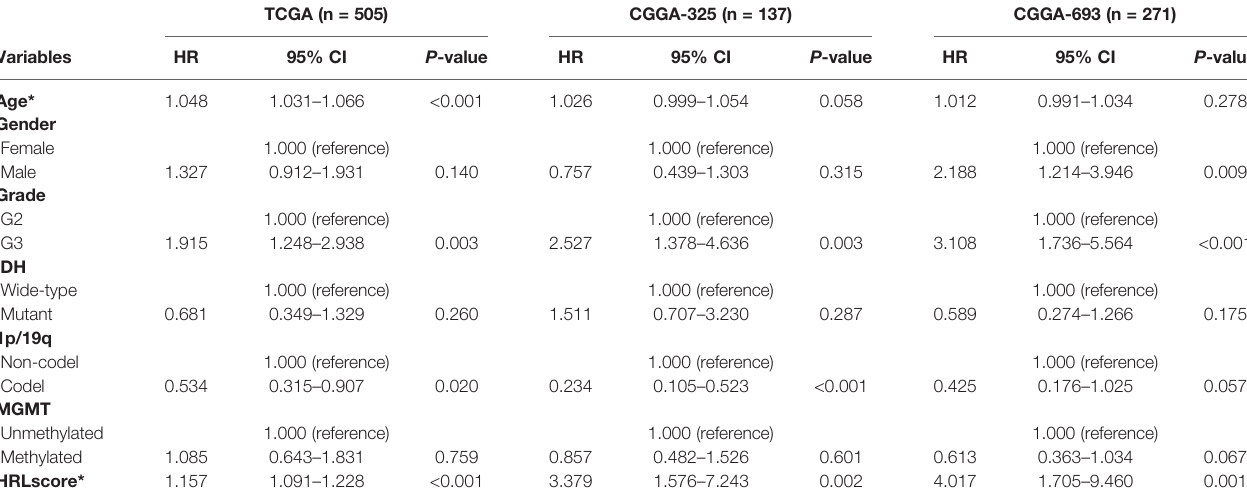
TABLE 2 | Multivariate Cox regression analysis for overall survival in lower-grade glioma